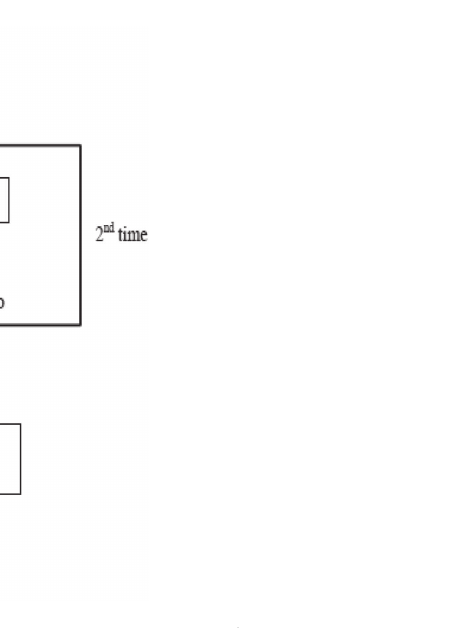
Figure 11: Call Flow Structure of Weather Information Spoken Query System (Reproduced from Ref. [32] for